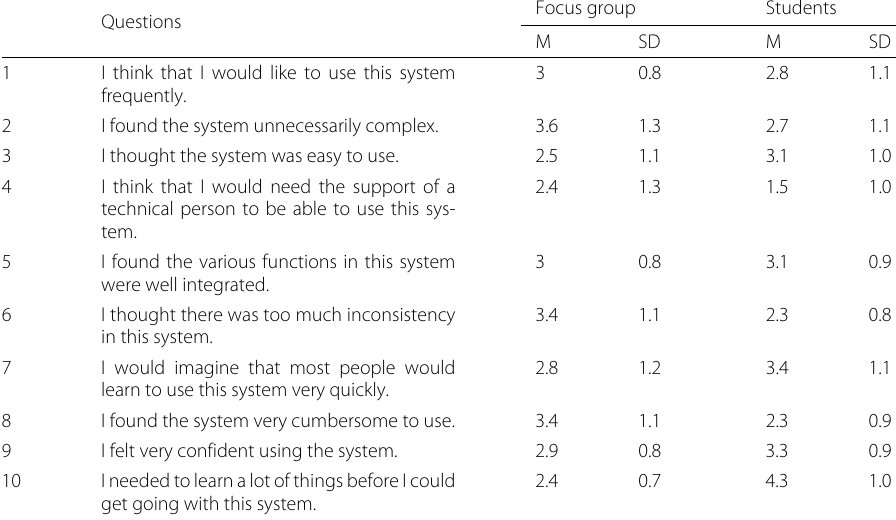
Table 3 Questions included in SUS